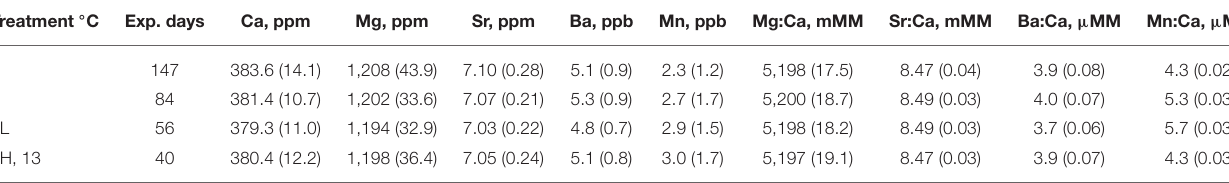
TABLE 3 | Mean (standard deviation) water elemental concentrations during the experiment. Treatment ◦ C Exp. days Ca, ppm Mg, ppm Sr,